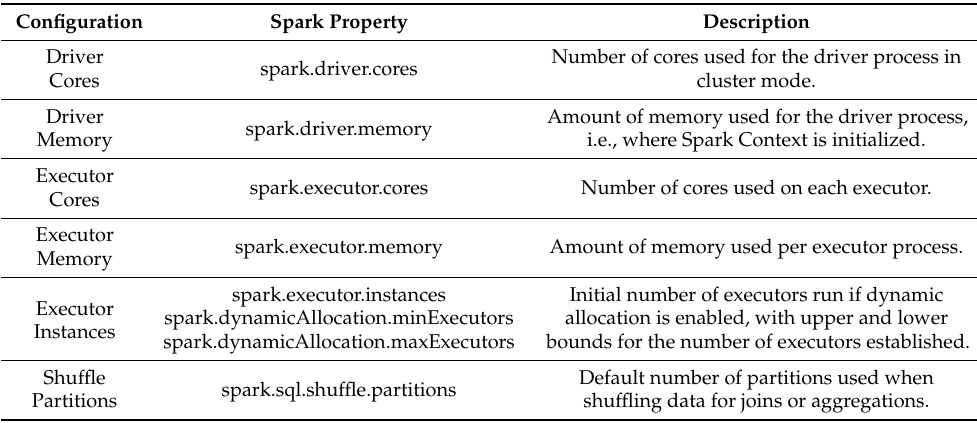
Table 14. Spark configuration parameters